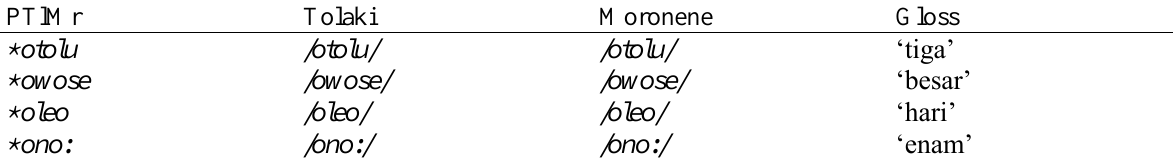
Table 14. initial position of the